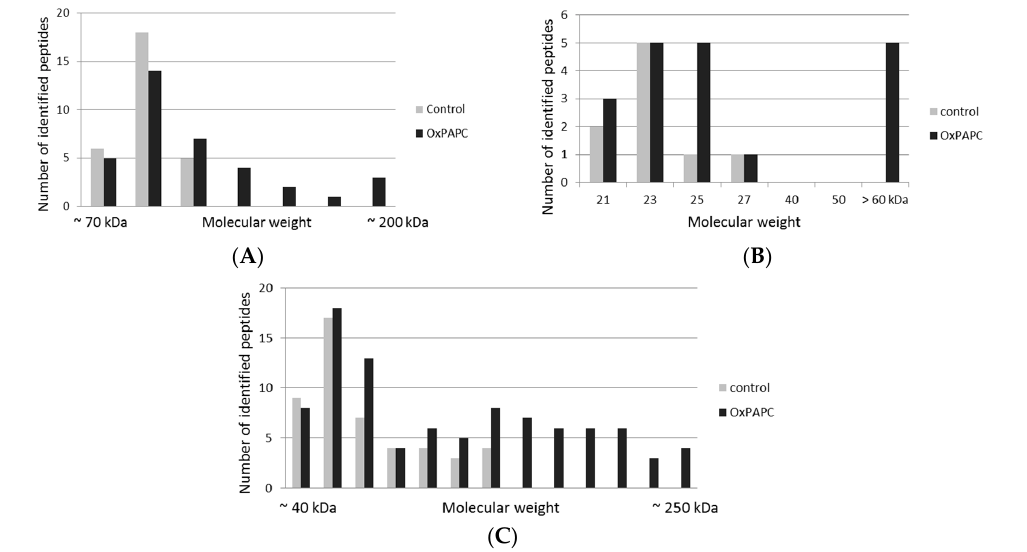
Figure 4. Peptide distribution of selected representative OxPAPC-modified proteins. A clear increase of peptides identified in higher molecular weight regions is observed after OxPAPC treatment. ( A ) Peptide distribution of HSP 90-beta; ( B ) Peptide distribution of VDAC-1; ( C ) Peptide distribution of Actin, cytoplasmic 1. Antioxidants 2018 , 7 , x FOR PEER REVIEW